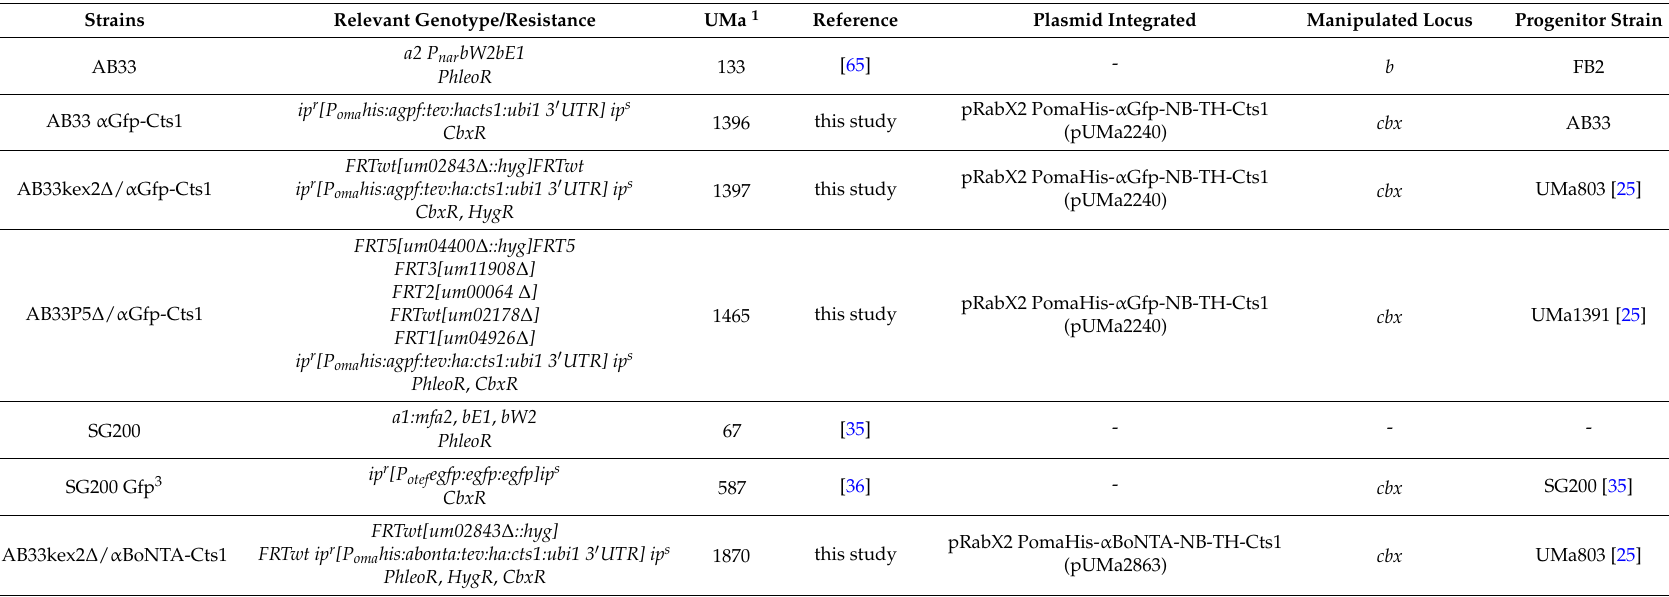
Table 2. U. maydis strains used in this study.